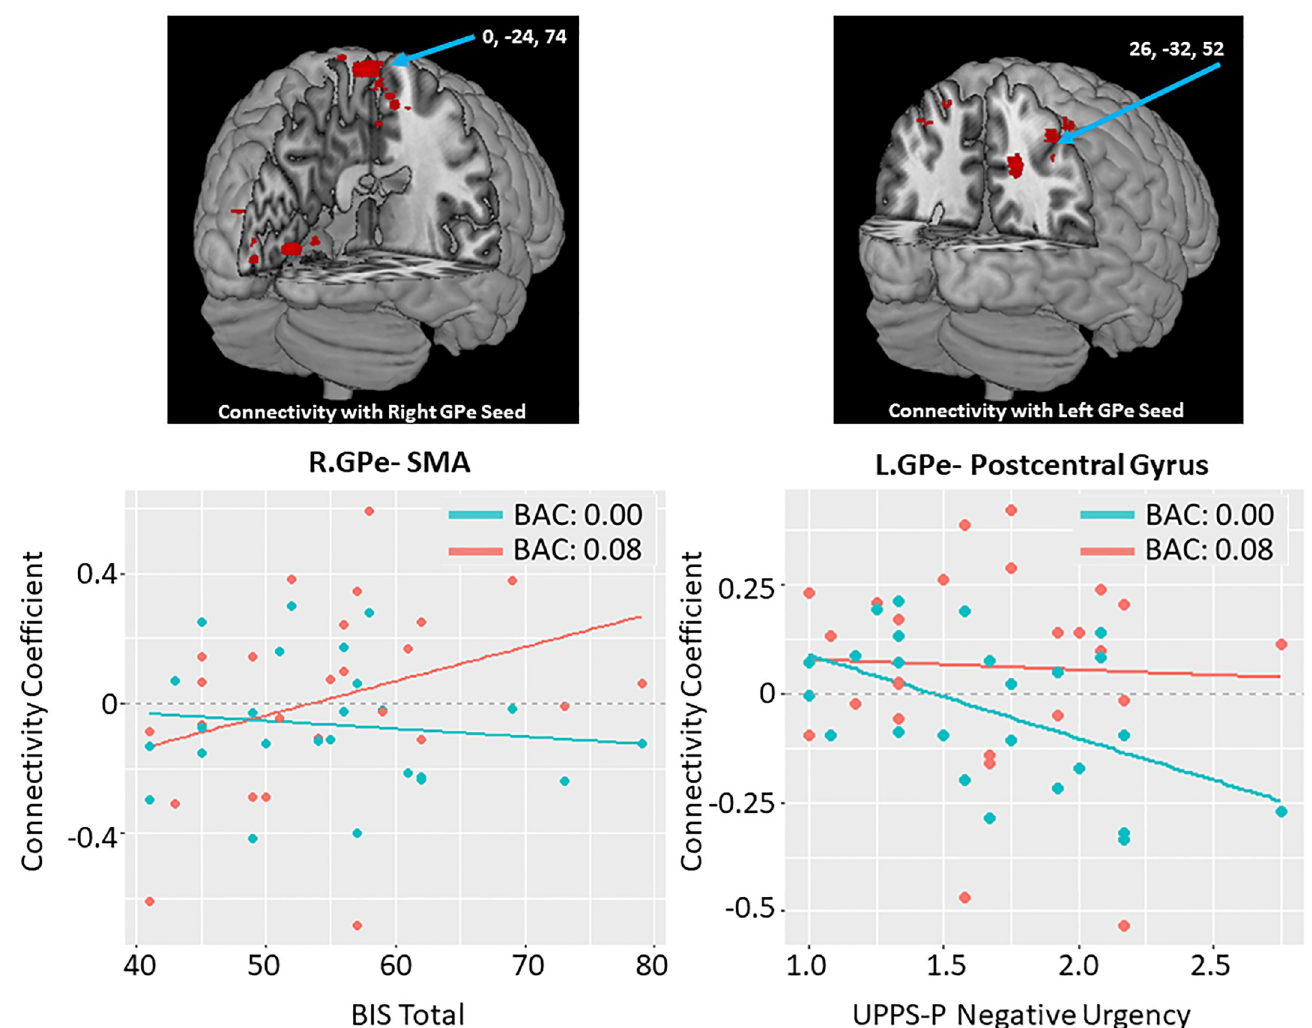
Fig 5. Association between impulsivity measures and alcohol induced changes in GPe connectivity. Scatter plots correspond to individual connectivity at baseline in teal (estimated BAC: 0.0) and after infusion in salmon (BAC: 0.08); linear fit lines are also displayed for each timepoint. Connectivity coefficient is the r (correlation value) between the signal in the GPe seed and the coordinate indicated. Brain images represent whole brain effects of drinks in past 30 days on alcohol induced change in functional connectivity (post-infusion connectivity > pre-infusion connectivity). Warm colors indicate intoxication related increases in connectivity. Images shown at p < 0.005. (left) Changes in connectivity plotted by total scores on the BIS (Barratt Impulsiveness Scale). (right) Changes in connectivity plotted scores on the UPPS-P negative urgency subscale. Reported clusters of connectivity with GPe area correspond to the following regions: (left) Precentral gyrus / SMA (supplementary motor area). Abbreviations: GPe- Globus Pallidus Externus; L.-Left; R.-Right.